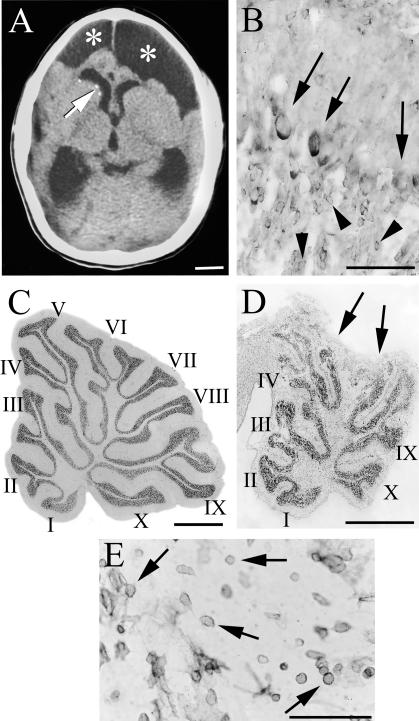
LCMV Infection Induces Focal Destructive Lesions within the Developing Brains of Humans and Rats(A) Head CT scan from a 4-mo-old child with congenital LCMV infection. The scan reveals bilateral asymmetric regions of encephalomalacia (asterisks), strongly suggestive of a focal destructive process. Note also the periventricular calcifications (arrow), characterisitic of a prenatal viral infection.(B) Section (50-μm-thick) through the cerebellar cortex of a neonatal rat infected with LCMV. The section has been immunohistochemically stained for LCMV antigens. The virus infects both Purkinje cells (arrows) and granule cells (arrowheads).(C) Nissl-stained section (2-μm-thick) through the cerebellar vermis of an uninfected (control) 30-d-old rat. The ten lobules of the cerebellar vermis (I–X) are labelled according to the system of Larsell [84].(D) Section (2-μm-thick) through the cerebellar vermis of a 30-d-old rat infected 3 wk earlier with LCMV. The dorsal cerebellum has undergone a destructive process (arrows). Most of lobules V, VI, VII, and VIII have been obliterated, while lobules I, II, III, and X have been relatively spared.(E) Section (50-μm-thick) through the cerebellar cortex of a 14-d-old rat infected 10 d earlier with LCMV. The animal was sacrificed at the time that acute destruction of the cerebellum was occurring. The section has been immunohistochemically stained for CD8+ antigen, which labels a subset of lymphocytes. Note the dense infiltration of CD8+ lymphocytes (arrows).Magnification bars represent 1 cm in (A), 100 um in (B), 500 um in (C), 500 um in (D), and 100 um in (E).